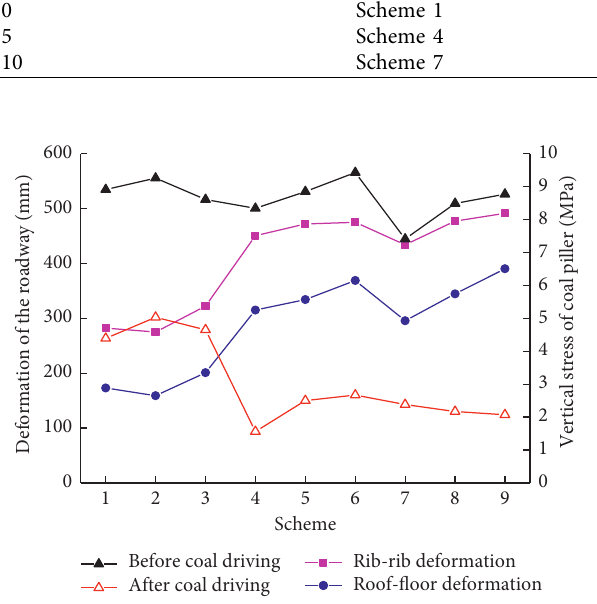
Figure 3: Display of relative deformation of surrounding rocks of roadways and vertical stress of the coal pillar.